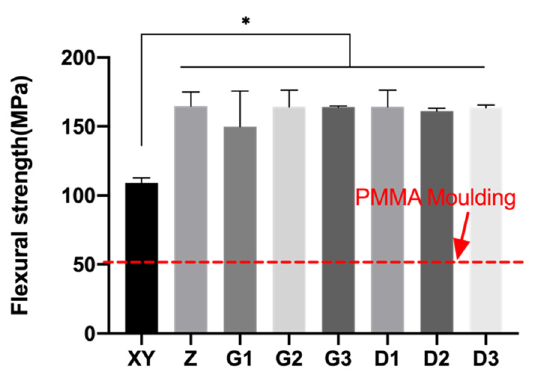
Figure 13. Mean and standard deviations of flexural strength of 3D-printed PEEK. * p <